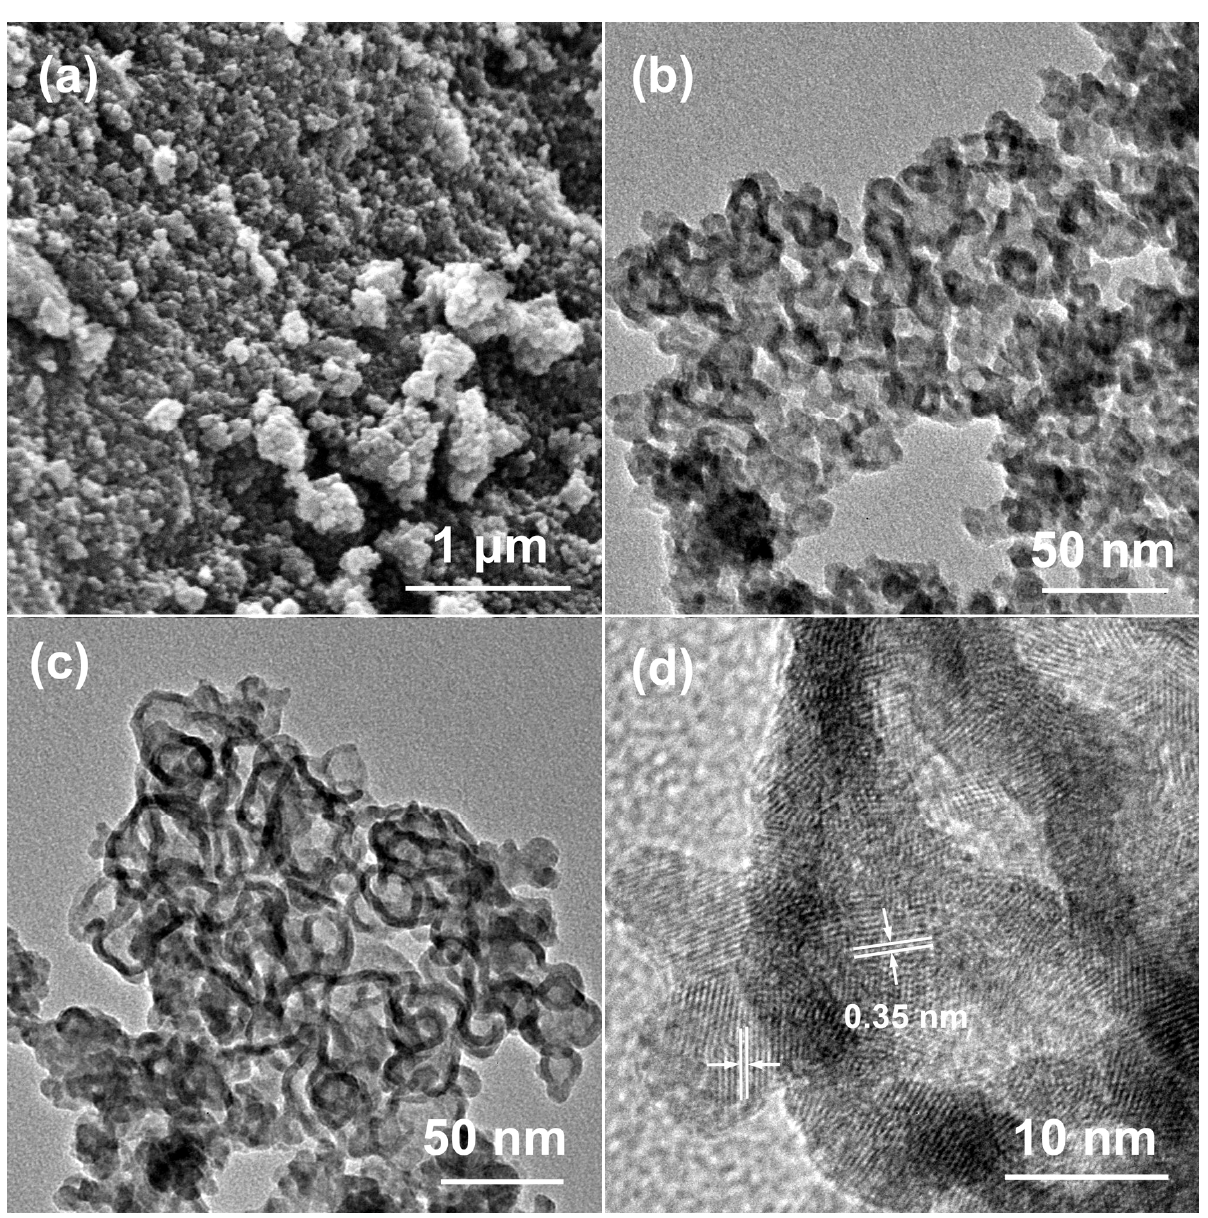
Figure 2. ( a ) SEM, ( b , c ) TEM and ( d ) HR-TEM images of CdS(HZ). The N 2 adsorption/desorption isotherm and pore size distribution of CdS(HZ) and CdS(no template) are illustrated in Figure 3. An IUPAC Type IV isotherm with a sharp capillary condensation step at high relative pressures and H1 type hysteresis loops are observed for CdS(HZ), which are characteristics of mesoporous materials. CdS(no tem- plate) also has a type IV isotherm, and its hysteresis loops is more likely to be H3 or